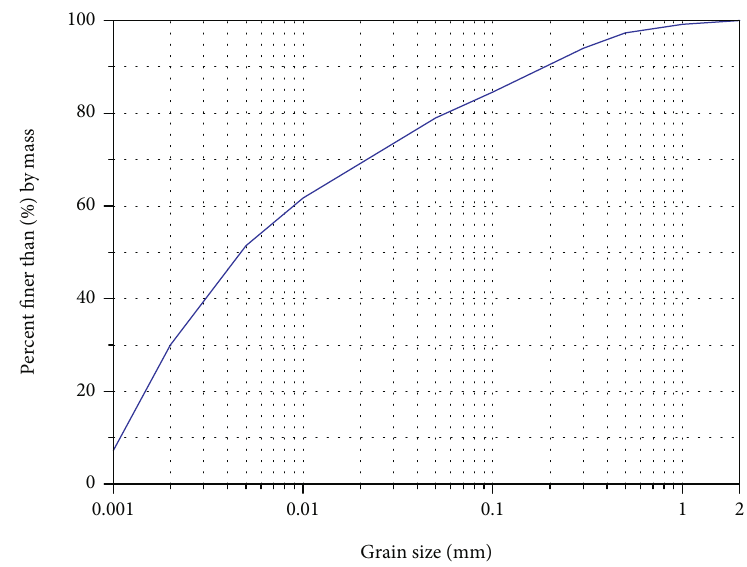
Figure 5: Soil grain size